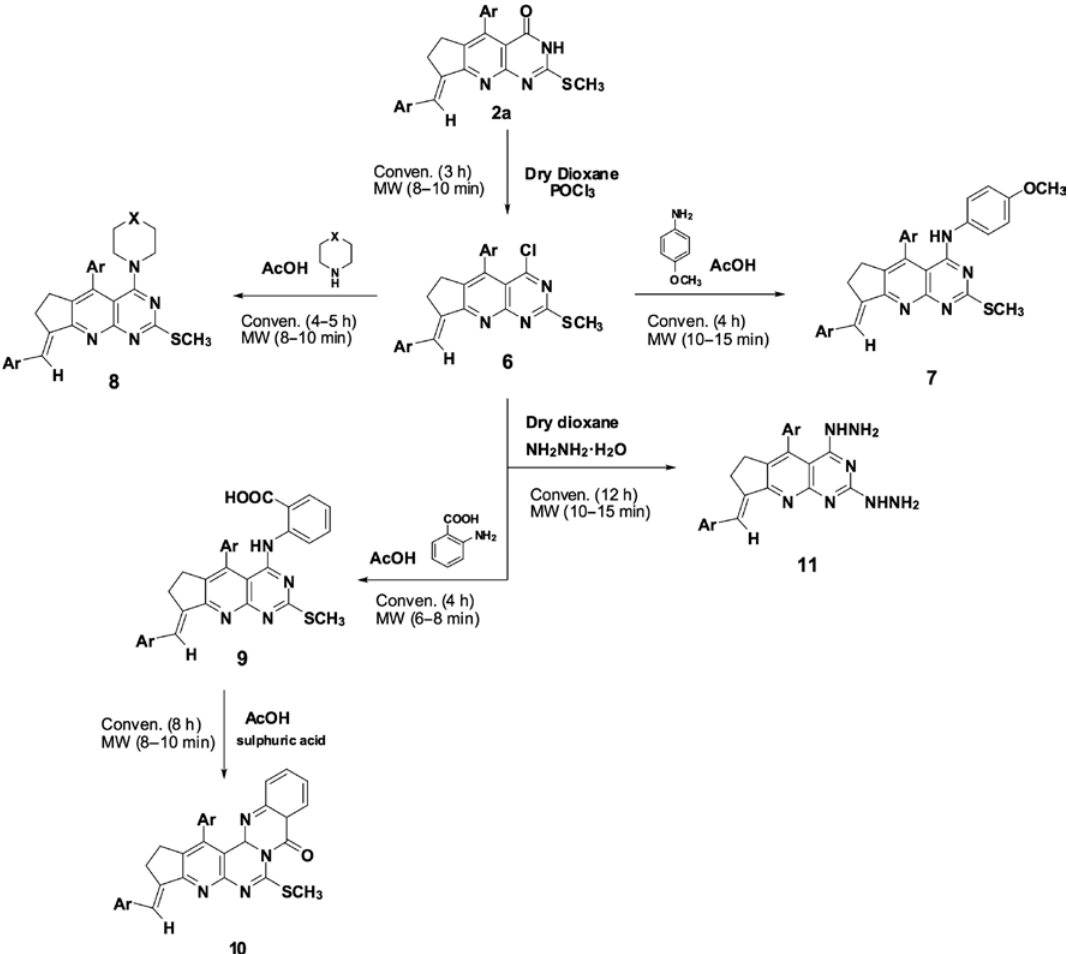
Scheme 2: The reaction of thiomethyl derivative 2a with different